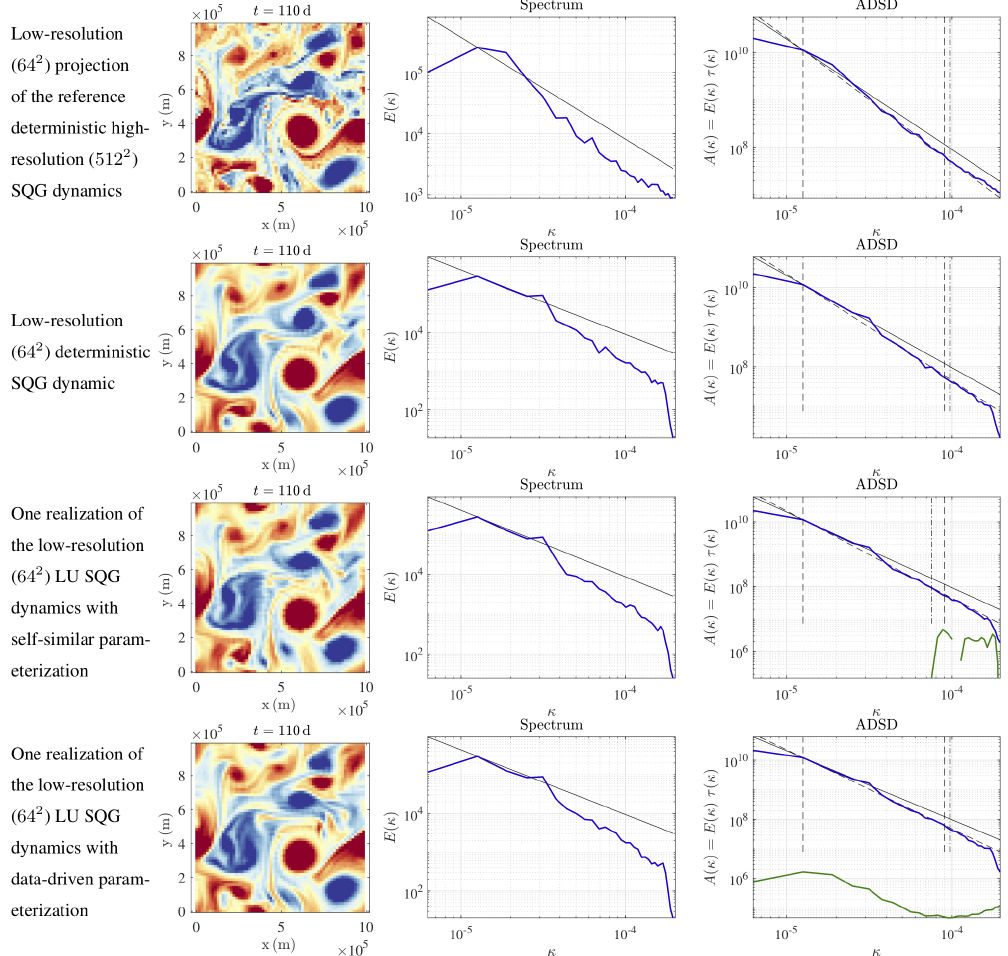
Figure 8. Buoyancy fields (ms − 2 ) (left), kinetic energy spectra (m 2 s − 2 / (radm − 1 )) (middle), and ADSDs (m 2 s − 1 / (radm − 1 )) (right) of w , in blue, ADSDs of σ ˙ B , in green, at t = 110d, for (from top to bottom) the low-resolution (64 2 ) projection of the reference deterministic high-resolution (512 2 ) SQG dynamics; the low-resolution (64 2 ) deterministic SQG dynamic; one realization of the low-resolution (64 2 ) LU SQG dynamics (equivalent to SALT SQG) with the self-similar parameterization; and one realization of the low-resolution (64 2 ) LU SQG dynamics (equivalent to SALT SQG) with data-driven